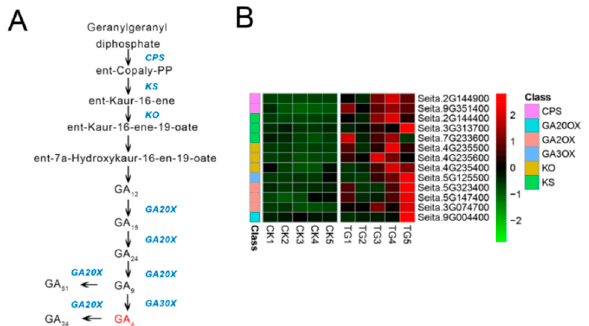
Figure 8. Gibberellin biosynthetic pathway and differentially expressed genes. ( A ) Gibberellin biosynthetic pathway. ( B ) Heatmap of differentially expressed genes related to this pathway. The FPKM values of the genes were normalized by Pheatmap package in R language before the heatmap was drawn. In the color legend on the right side of the heatmap, the color labels of each gene correspond to the bar graph on the left side of the heatmap. The experiment was repeated at least three times and the results were similar. The heatmap data are the average of the repeated FPKM values.